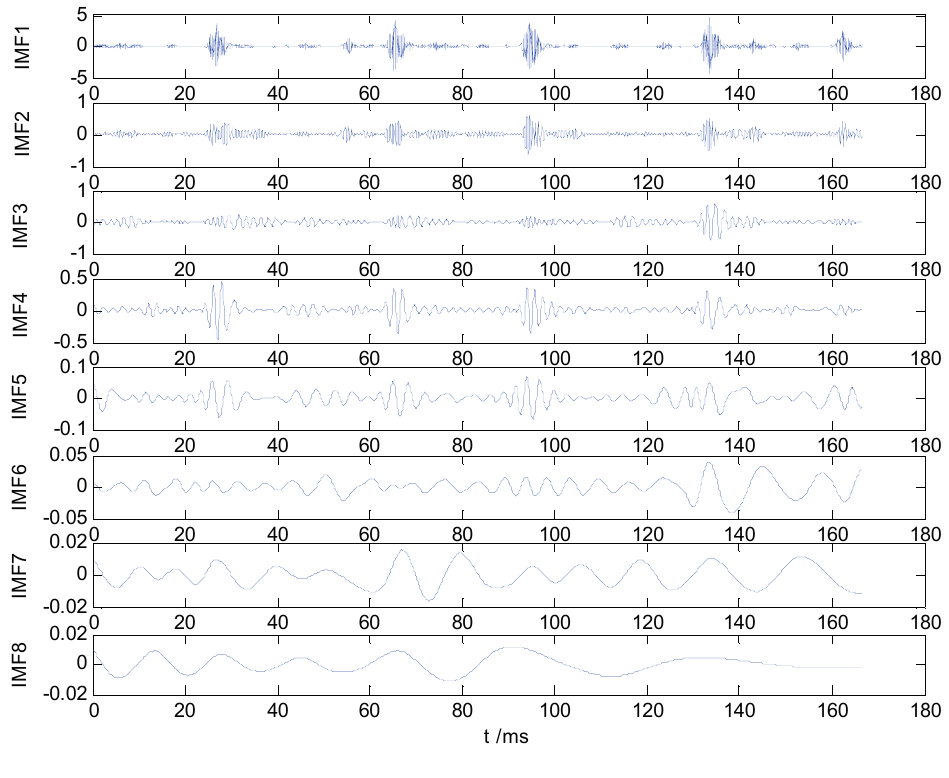
Figure 4. IMF1–IMF8 of ORF vibration